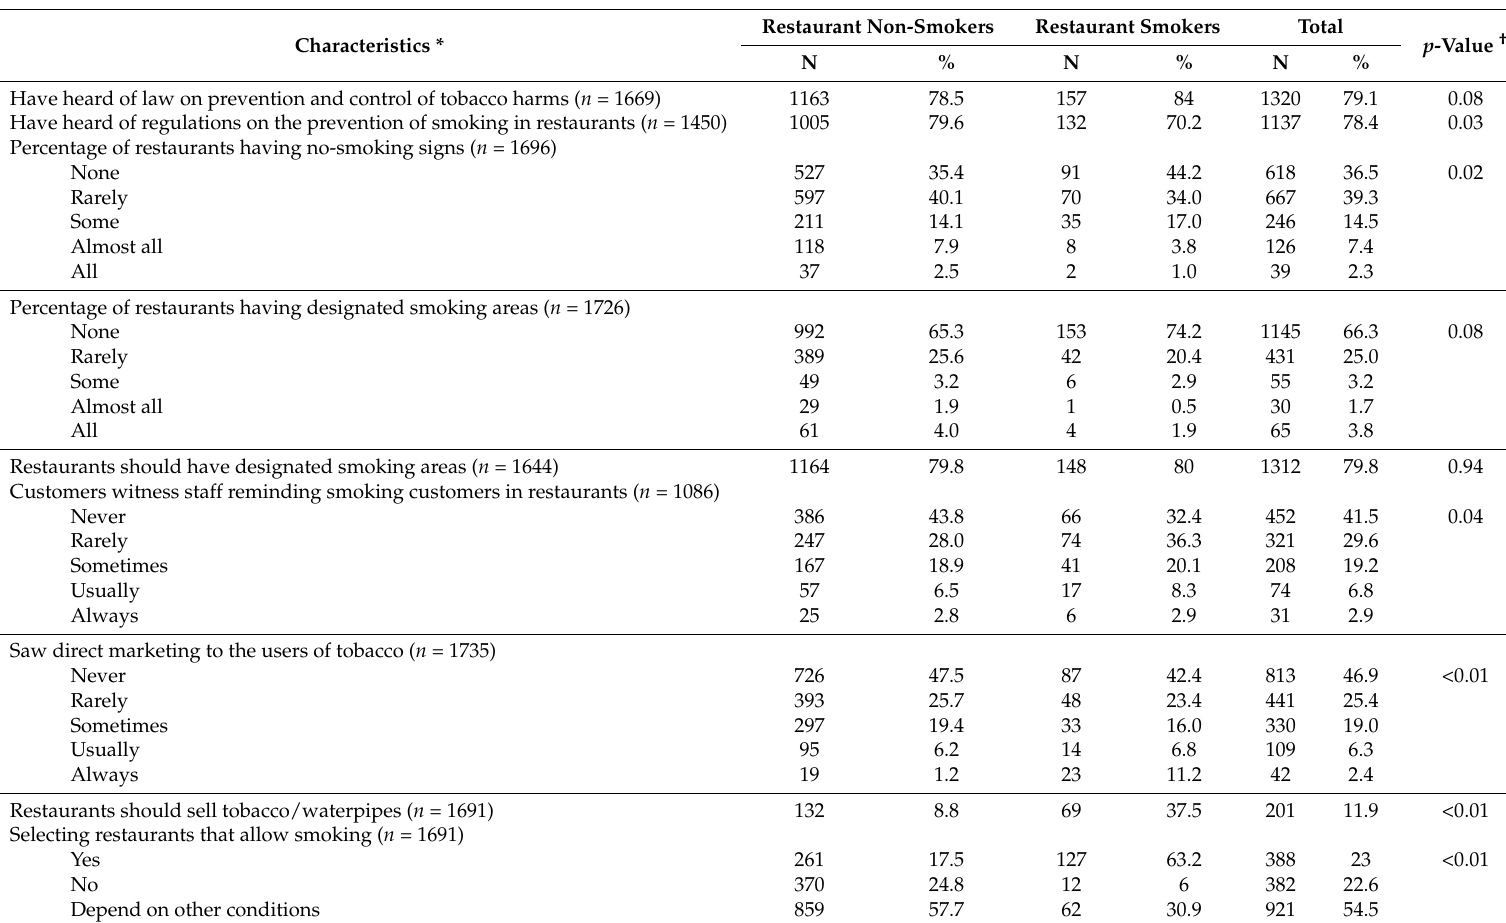
Table 2. Customers’ perception of the compliance with “Prevention and control of tobacco harms law” according to smoke-free law of the restaurant. Restaurant Non-Smokers Restaurant Smokers Characteristics *